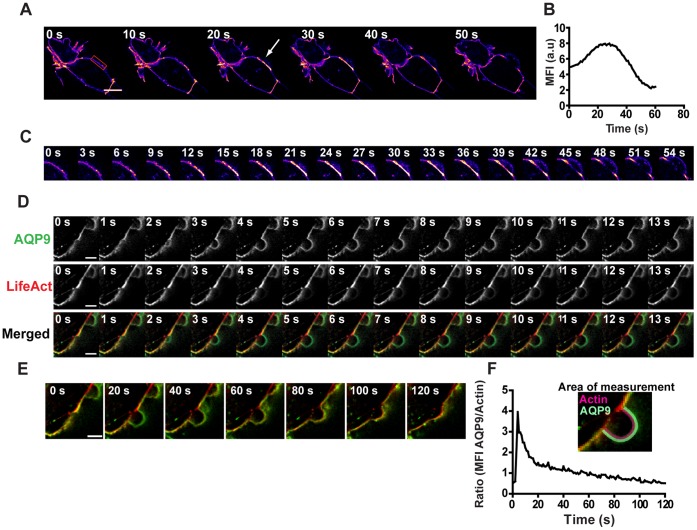
Water fluxes across AQP9 induce blebs.(A) A confocal time-lapse montage of HEK-293 cells stably overexpressing GFP-AQP9. The images are linearly adjusted and pseudo-colored in fire scale to visualize fluctuations in fluorescence intensity. The arrow is pointing towards GFP-AQP9 accumulation in the membrane Scalebar 10 µm. The red box represents the area of measurement for MFI in (B). A smoothing filter was applied to this image to reduce background. (B) MFI-measurement of the blebbing membrane throughout the time-lapse. The area of measurement is presented in (A). (C) Zoom in panel of the blebbing membrane presented in (A). (D) Representative confocal time-lapse montage of a blebbing HEK-293 cell expressing both GFP-AQP9 and tagRFP-LifeAct. Scalebar 5 µm. (E) The same montage as presented in (D) showing a longer acquisition time to illustrate the complete lifetime of the same bleb. (F) Ratio measurements obtained from the sequence presented in (E). The ratio is measured as AQP9 MFI in the bleb membrane divided by submembraneous actin MFI showing a rapid initial increase in ratio due to the absence of actin during bleb formation. The ratio subsequently decreases due to increasing actin fluorescence in the bleb. The insert is a representative image showing the area of measurement for AQP9 and actin.